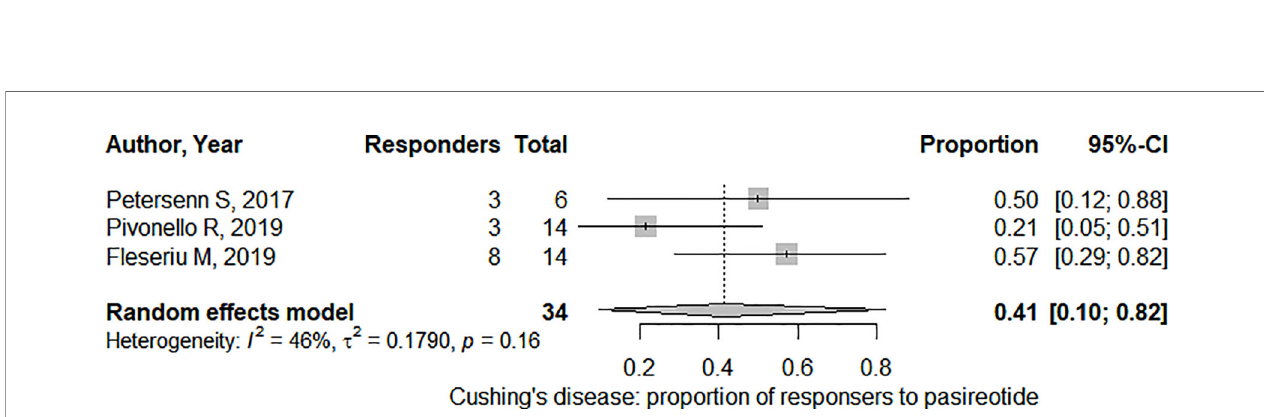
FIGURE 5 | Pooled effect for the proportion of responders (i.e. presenting signi fi cant tumor shrinkage) in Cushing ’ s Disease. CI, con fi dence